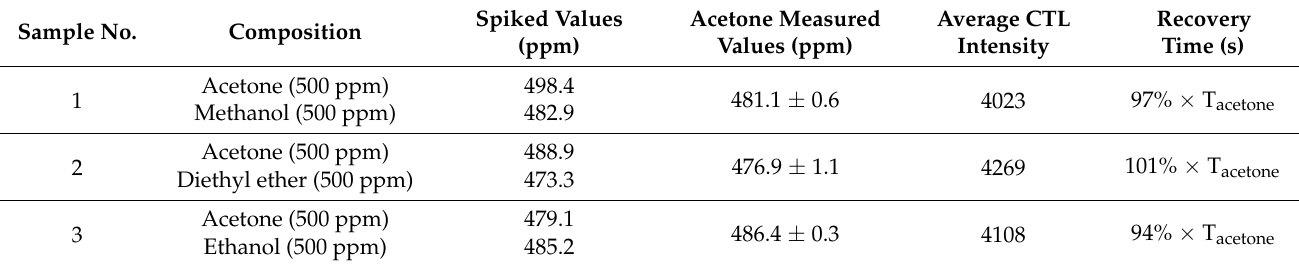
Table 1. Determination Result of Acetone in Artificial